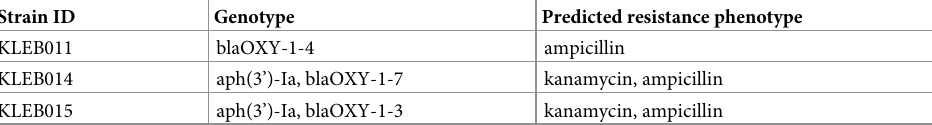
Table 2. Antibiotic resistance genes in K . michiganensis strains KLEB011, KLEB014 &